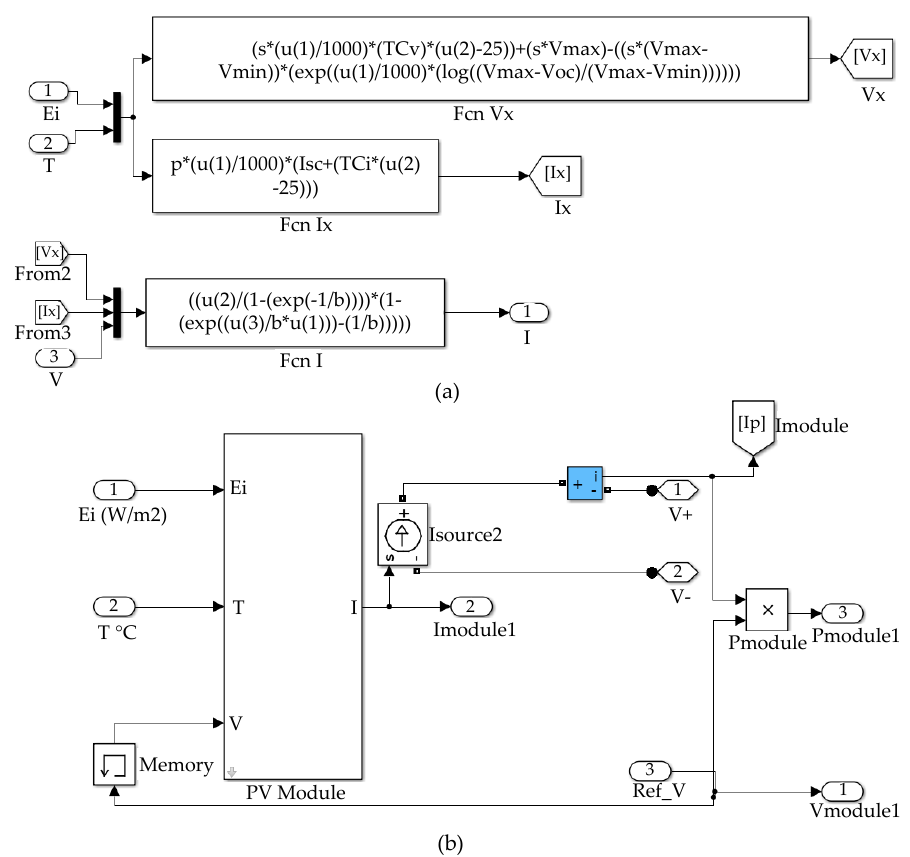
Figure 2. PV module in Matlab. ( a ) Model implemented with Simulink function blocks; ( b ) Subsystem implemented for the simulation.